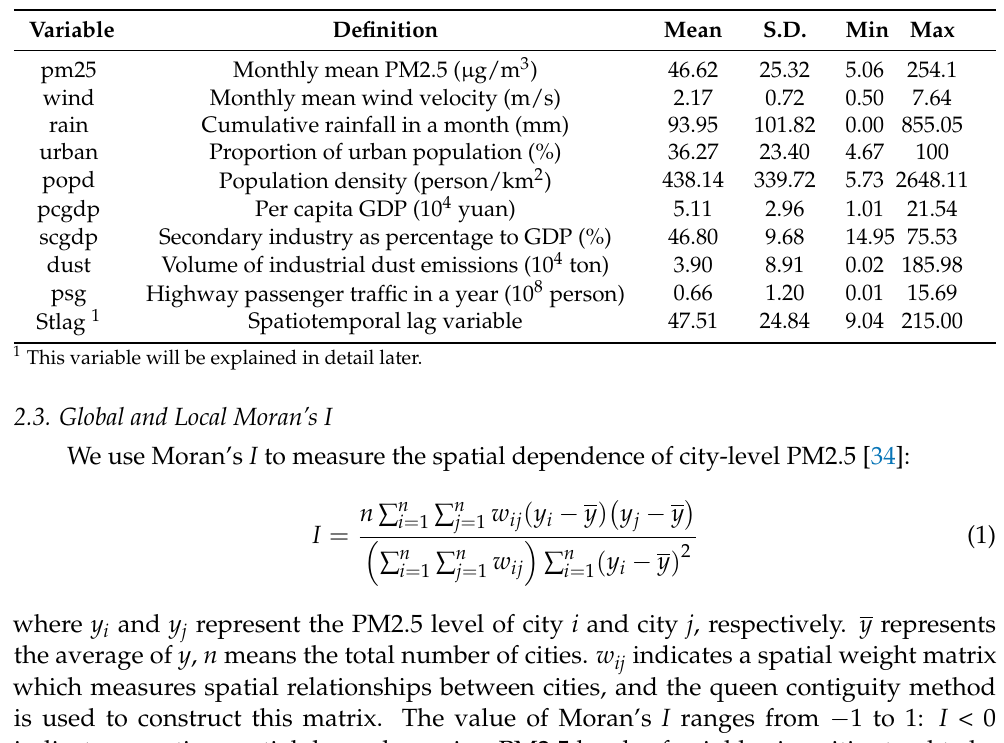
Table 1. Descriptive statistics of